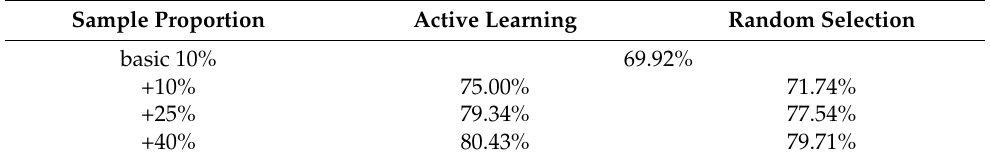
Table 6. Overall accuracy comparison of sample selection methods: active learning and random selection.